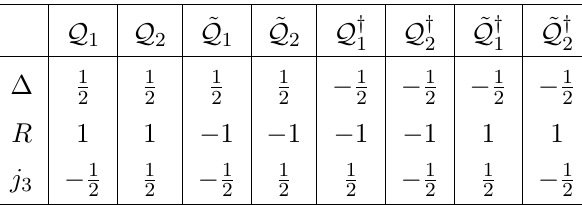
Table 1 . Global charges of supersymmetry generators of the 3d N = 2 superconformal